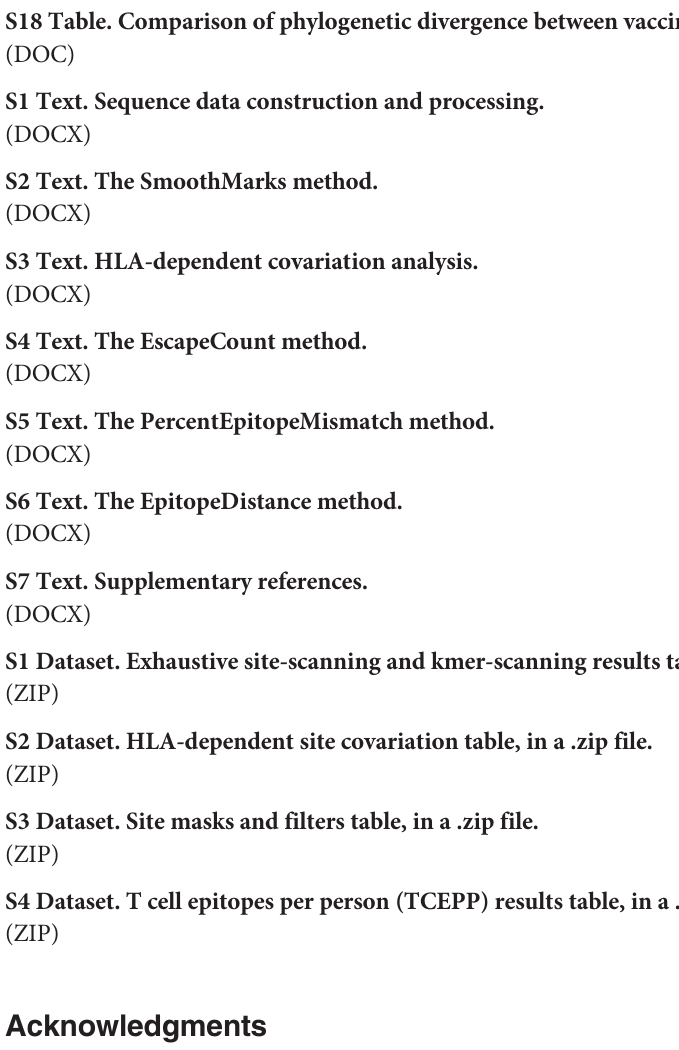
S18 Table. Comparison of phylogenetic divergence between vaccine and placebo